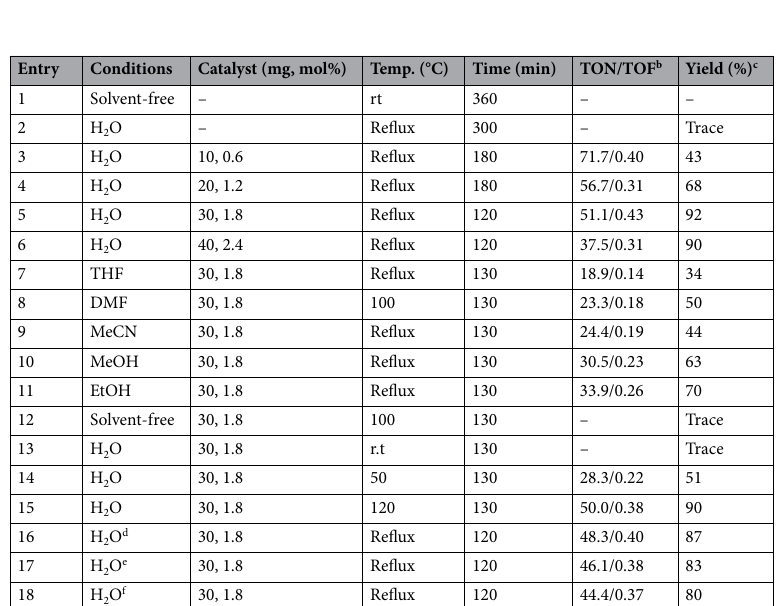
Table 1. Screening of the reaction conditions for the synthesis of 4a a . a Reaction condition: Benzyl bromide (1 mmol), phenylacetylene (1 mmol), sodium azide (1.2 mmol). b Turn Over Number (yield of the reaction/ mol%)/Turn Over Frequency (TON/time of the reaction). c Based on isolated yield. d In the presence of HKUST-1. e In the presence of Cu(OAc) 2 . f In the presence of CuCl 2